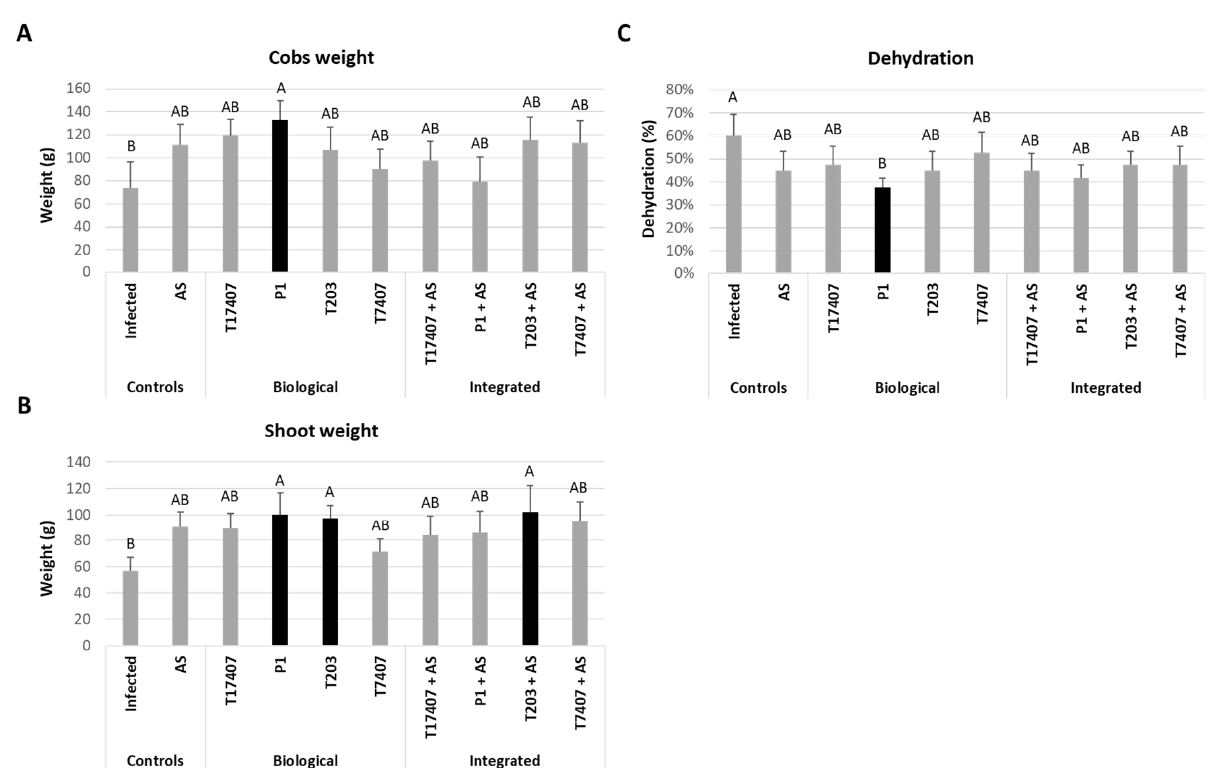
Figure 9. The open-enclosure trial growth parameters at harvest (day 78). The experiment is described in Figure 6. The estimation included fresh weight of the cobs ( A ), shoot wet biomass of the plants ( B ) and total dehydration (wilting) assessment according to four categories: 1—healthy, 2—symptoms, 3—diseased and 4—dead ( C ). Each value is a mean of 9–10 repetitions (plants per treatment). Error bars indicate standard error. Different letters above the chart’s bars (A,B) represent an ANOVA test significant difference ( p < 0.05).